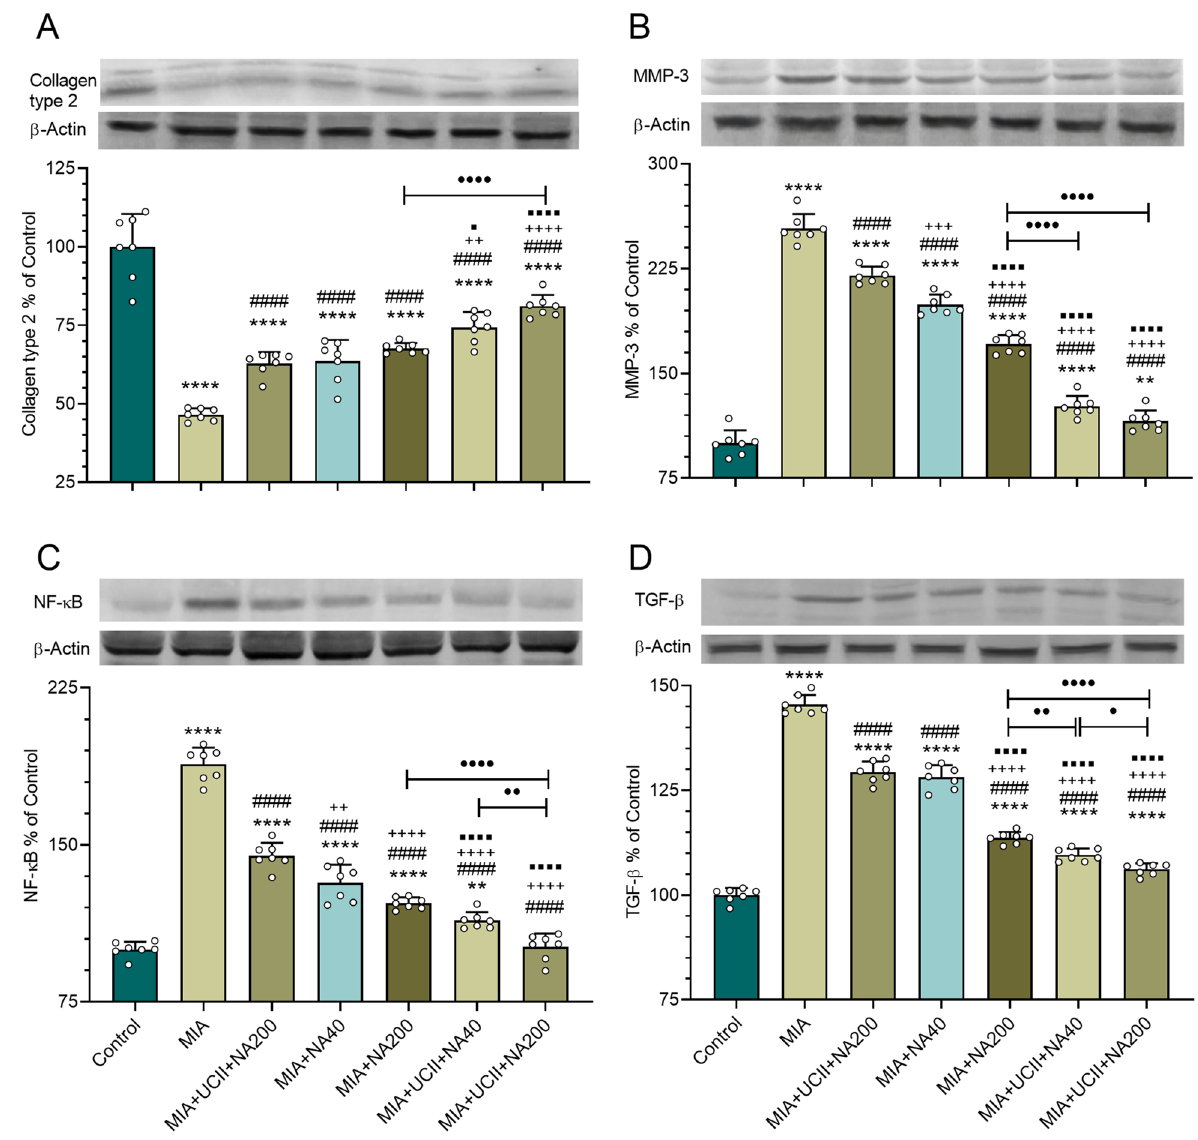
Figure 7. Effects of niacinamide (NA) and undenatured type II collagen (UCII) supplementation on the knee joint collagen type II ( A ), MMP-3 ( B ), NF-κB ( C ), and TGF-β1 ( D ) levels in monosodium iodoacetate (MIA)- induced osteoarthritis in rats. The densitometric analysis of the relative intensity according to the control group of the western blot bands was performed with β-actin normalization to ensure equal protein loading. Blots were repeated at least three times (n = 3), and a representative blot is shown. Data are expressed as a percent of the control set at 100%. Control as a non-supplemental group with no osteoarthritis-induced rats, MIA as a non-supplemental group with monosodium iodoacetate (MIA)-induced knee osteoarthritis, MIA + UCII as MIA group gavage-fed a supplemental UCII at 4 mg/kg, MIA + NA40 as MIA group gavage-fed supplemental niacinamide (NA) at 40 mg/kg, MIA + NA200 as MIA group gavage-fed a supplemental NA at 200 mg/kg, MIA + UCII + NA40 as MIA group gavage-fed both supplemental UCII at 4 mg/kg and NA at 40 mg/kg, and MIA + UCII + NA200 as MIA group gavage-fed both supplemental UCII at 4 mg/kg and NA at 200 mg/kg. Oral gavage delivery of supplements was applied from d7 to d30. The error bars point out the standard deviation of the mean. (ANOVA and Tukey’s post-hoc test were used for comparing the results among different treatment groups. Full-length blots are presented in Supplementary Fig. S3. Statistical significance between groups is shown by: ** p < 0.01; **** p < 0.0001 compared as Control group and, #### p < 0.0001 compared as MIA group and, ++ p < 0.01; +++ p < 0.001; ++++ p < 0.0001 compared as MIA + UCII group and, ⬛ p < 0.05; ⬛⬛⬛⬛ p <